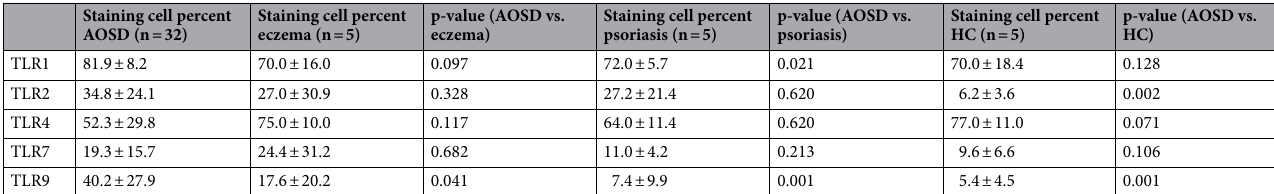
Table 4. Toll-like receptor (TLR) immunostaining results in skin biopsies from patients with adult-onset Still’ disease (AOSD), eczema, and psoriasis and healthy controls (HC). p-values determined using a Mann– Whitney U-test. AOSD, adult-onset Still’s disease; HC, healthy